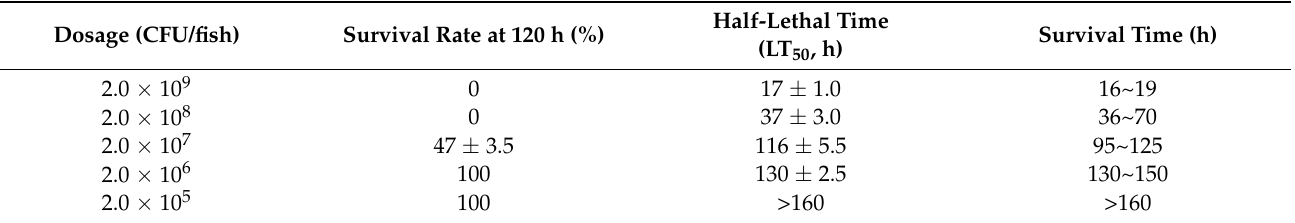
Table 2. Survival rate of golden pompano induced by intraperitoneal injection of S. agalactiae and the survival time corresponding to each